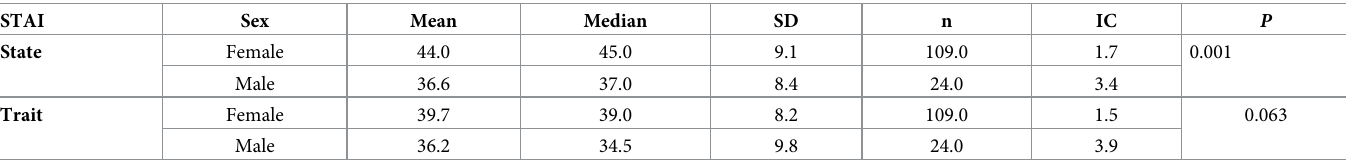
between patient assessment of the amount of information received from the referring physi- cian and STAI-State anxiety scores ( p = 0.006) (Table 3). As this parameter had three possible responses, the Mann-Whitney test was used to compare responses two by two. Statistical sig- nificance was found in the comparisons between the responses “limited information” and “all necessary information,” and between “almost all necessary information” and “all necessary information” ( p < 0.05 ) . The relationship between the patients’ self-assessed proactivity and STAI scores are shown in Table 4.